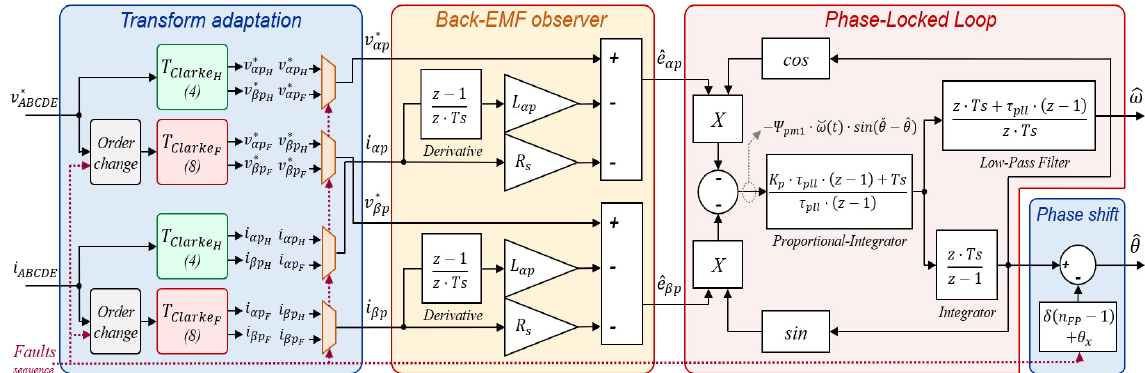
Figure 18. Synoptic of the Back-EMF-based estimator.